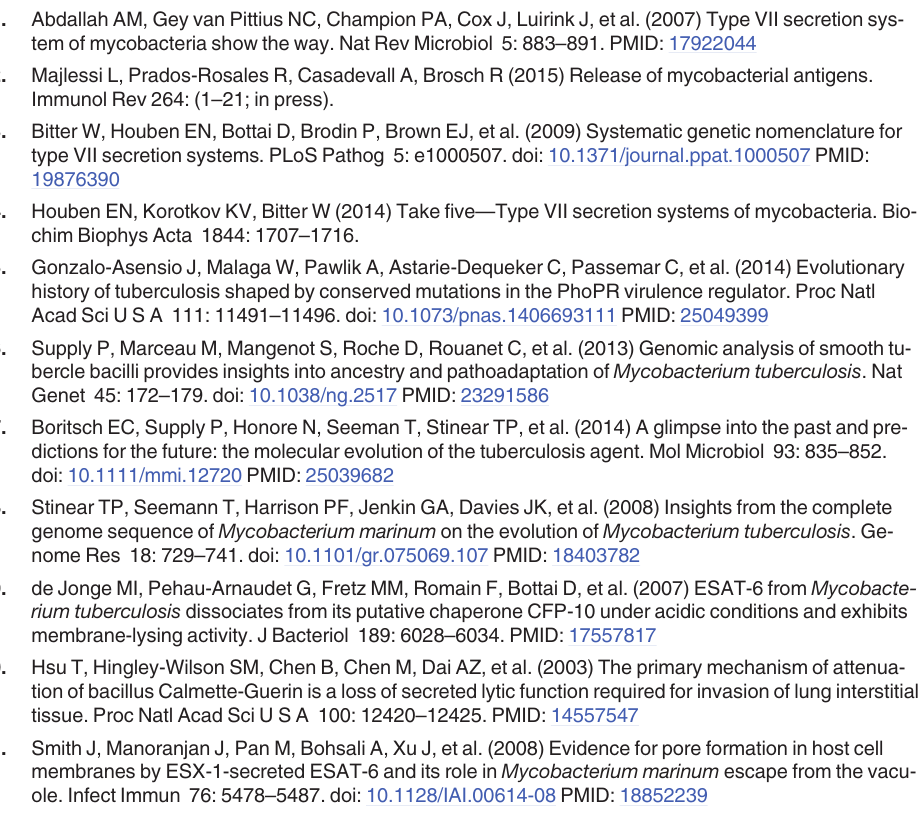
S7 Fig. Gating strategy on CD45.1 donor innate cells adoptively transferred into the CD45.2 recipients. BM-DC from CD45.1 donor mice, non-infected or infected with Mtb Δ ESX-1 or WT, were transferred i.n. into the CD45.2 recipients. Shown are the low-density cells recovered from the lung parenchyma of the recipients of each group at day 4 post transfer. Cells were first gated on FSc/CD11b and then for CD45.1 + cells. The comparative CCF-4 blue signal of such cells from different experimental groups are shown in Fig.